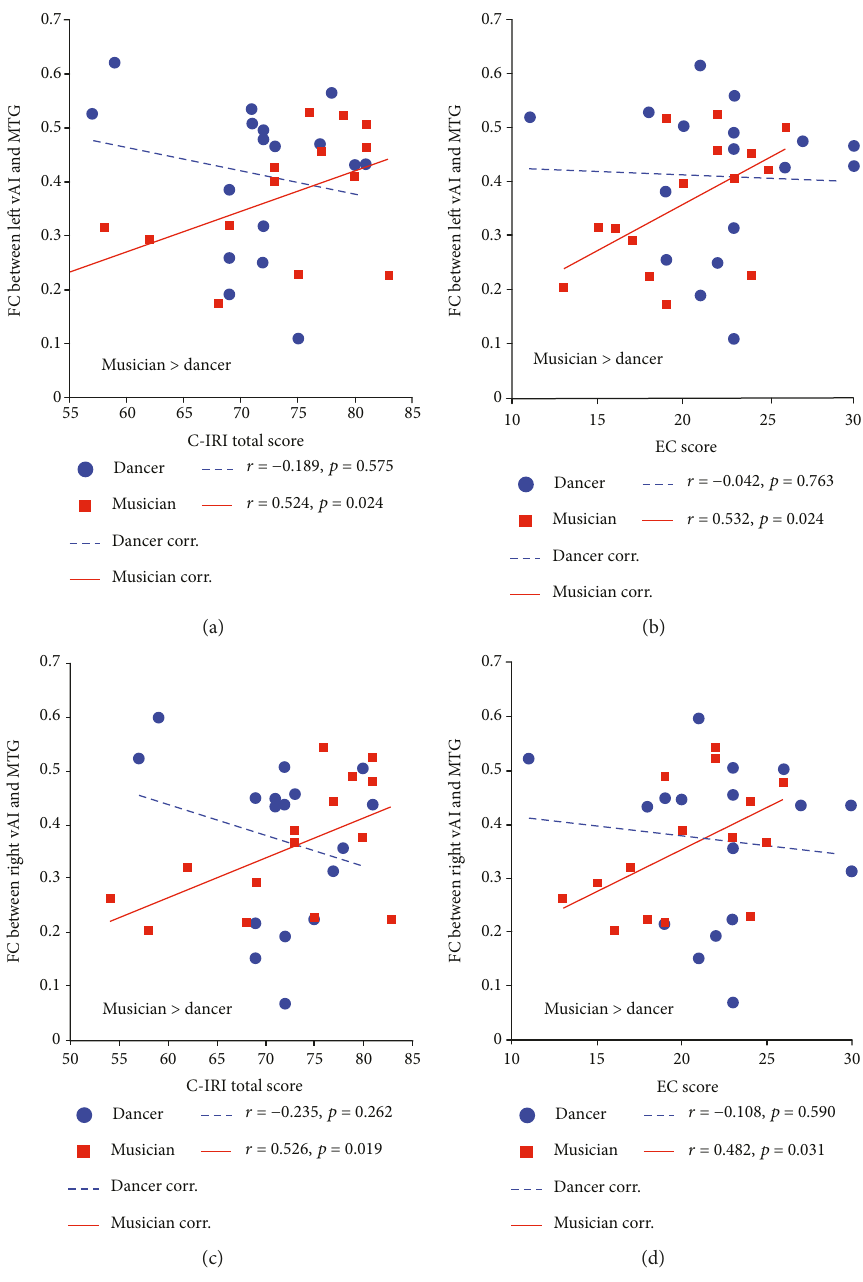
Figure 5: The positive associations between C-IRI scores and FC in the musician group. Linear partial correlation coe ffi cients between FC and C-IRI scores in dancers (blue broken line) and musicians (red solid line). (a) Shows correlations between FC (between left vAI and MTG) and C-IRI total scores. (b) Shows correlations between FC (between left vAI and MTG) and EC scores. (c) Shows correlations between FC (between right vAI and MTG) and C-IRI total scores. (d) Shows correlations between FC (between right vAI and MTG) and EC